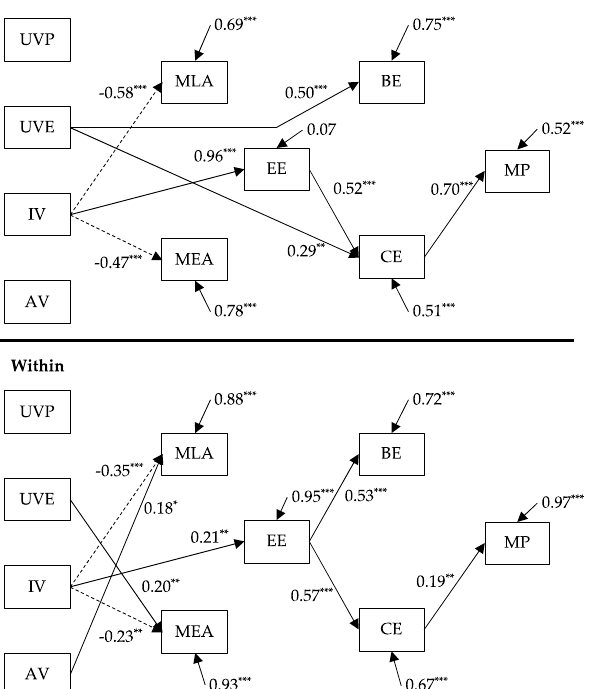
Figure 2. Results of multilevel structural equation modelling. UVP, utility value for practice; UVE, utility value for the entrance examinations; IV, interest value; AV, attainment value; MLA, math learning anxiety; MEA, math evaluation anxiety; EE, emotional engagement; BE, behavioral engage- ment; CE, cognitive engagement; and MP, mathematical problem solving. The values in the figure are standardized path coefficients and error variance. In particular, the values of the standardized error variance in the between model represent the random intercept. Solid lines represent positive relations; dashed lines represent negative relations. *** p < 0.001, ** p < 0.01, * p < 0.05.